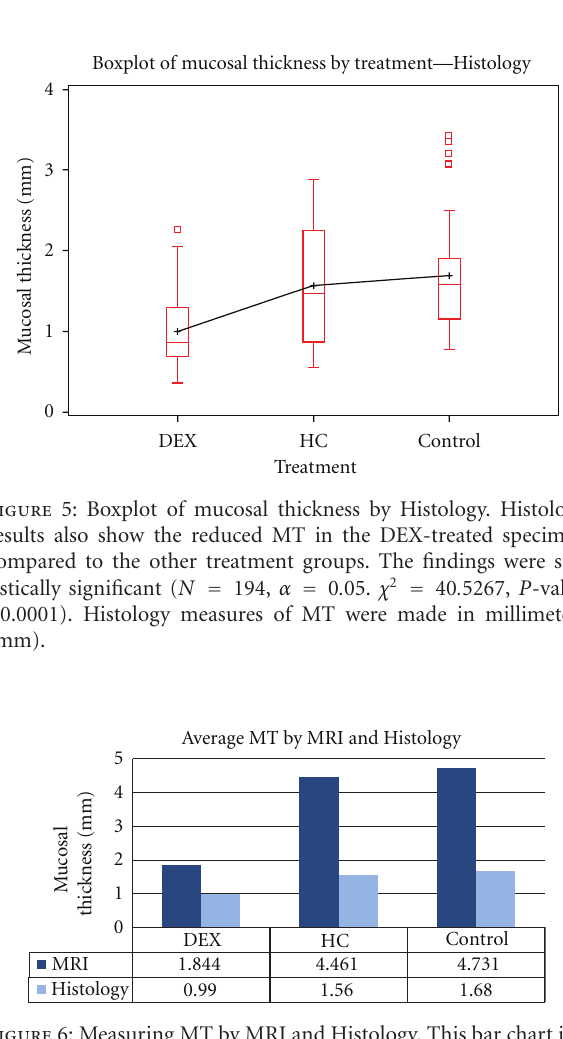
Figure 6: Measuring MT by MRI and Histology. This bar chart is a comparison of two methods for measuring MT, which show compa- rable findings. Both MRI and Histology methods reveal that DEX- treated chinchillas produced less mucosal thickness when compared to HC-treated and control groups. The disparity in the MT thick- ness is likely due to the specimen handling during histology, which requires use of various desiccating substances.